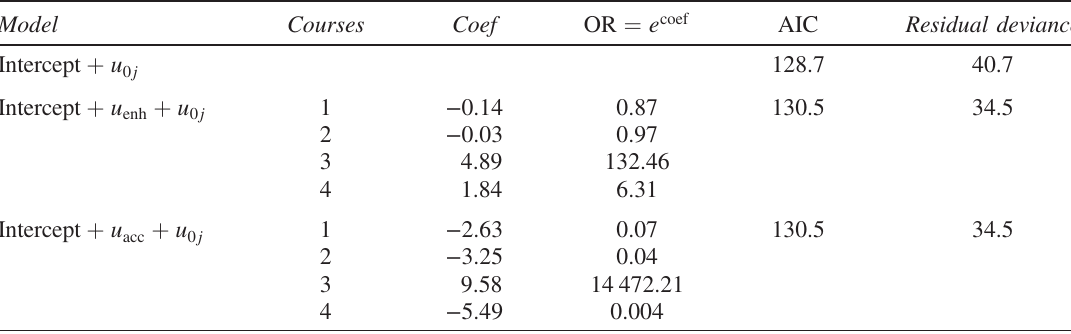
TABLE V. Results of multinomial logistic regressions for models with substantial support, when the outcome was the number of passed courses ( N ¼ 20 , compared to courses ¼ 0 ).